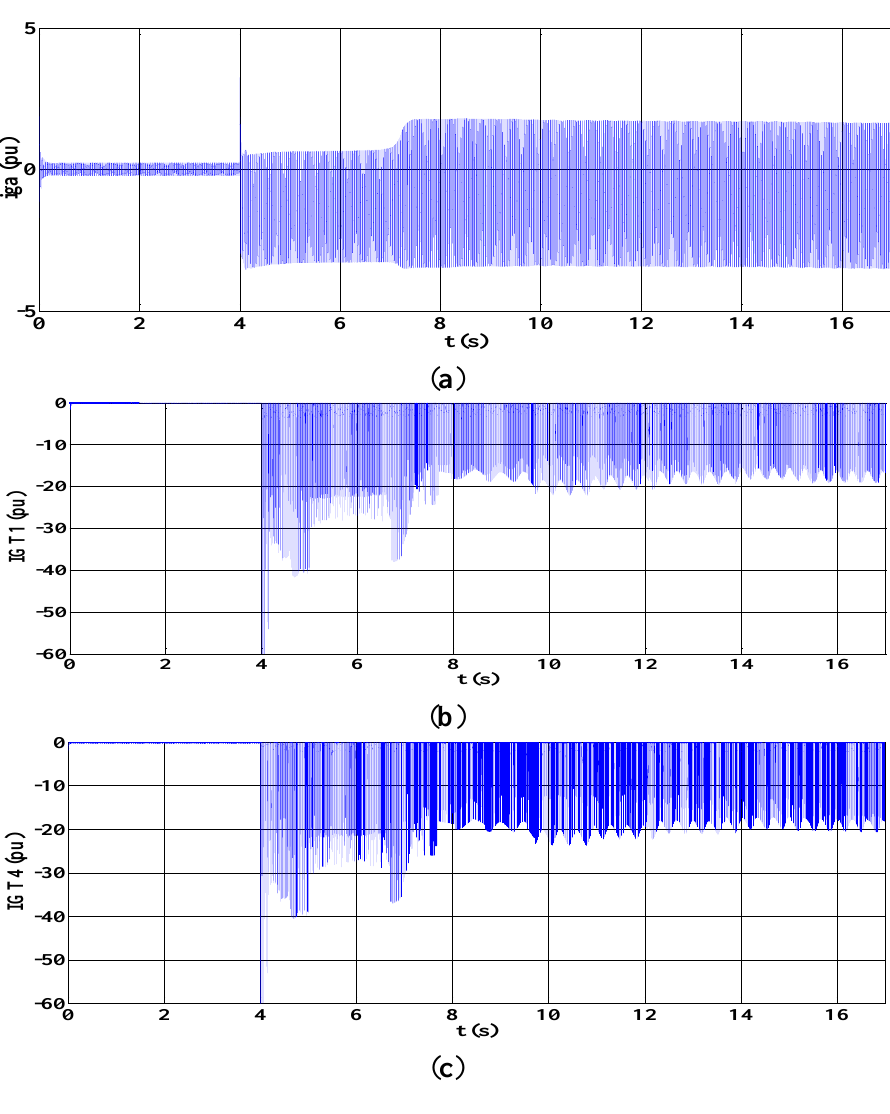
Figure 15. Waveforms of the characteristic variables of the Grid Side Converter (GSC): ( a ) Grid Side Converter (GSC) phase current i ga , ( b ) Current through Insulated Gate Bipolar Transistor (IGBT) (1), ( c ) Current through Insulated Gate Bipolar Transistor (IGBT) (4) (short-circuit happens at t = 4 s for all waveforms).